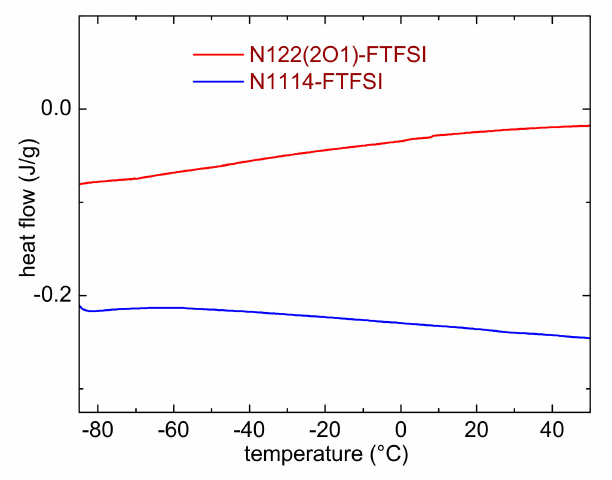
Figure 3. Differential scanning calorimetry curves of the investigated ILs.